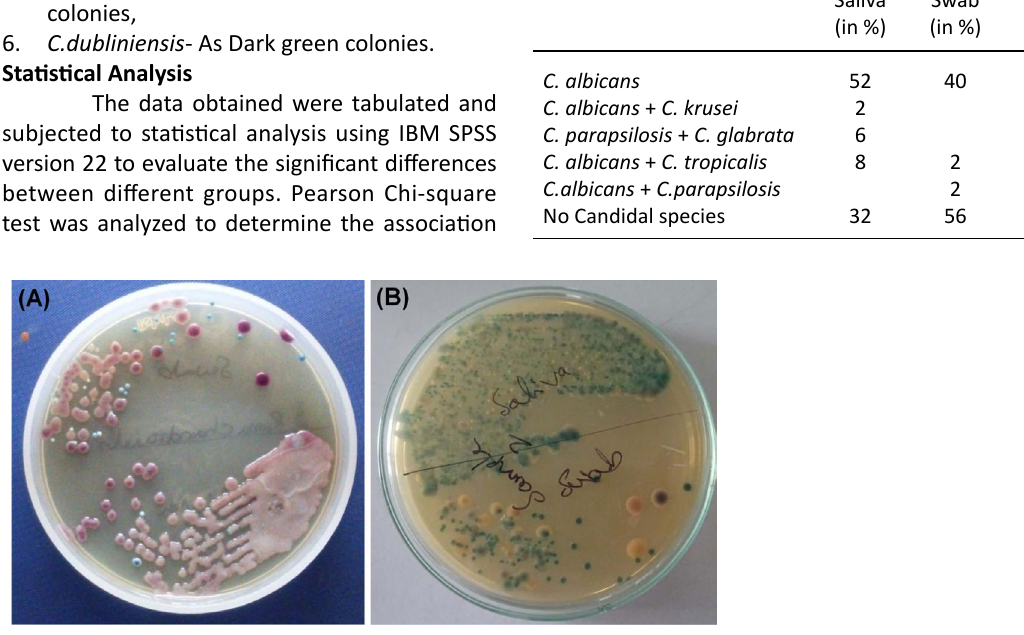
Fig. 1. Growth of different fungal colonies from salivary and swab samples (A) Candida albicans (B) Candida